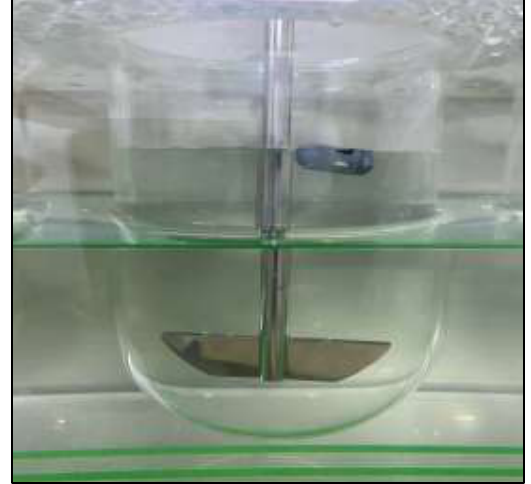
Figure 3. Gastro-floating device with F5 sustained-release tablet inside